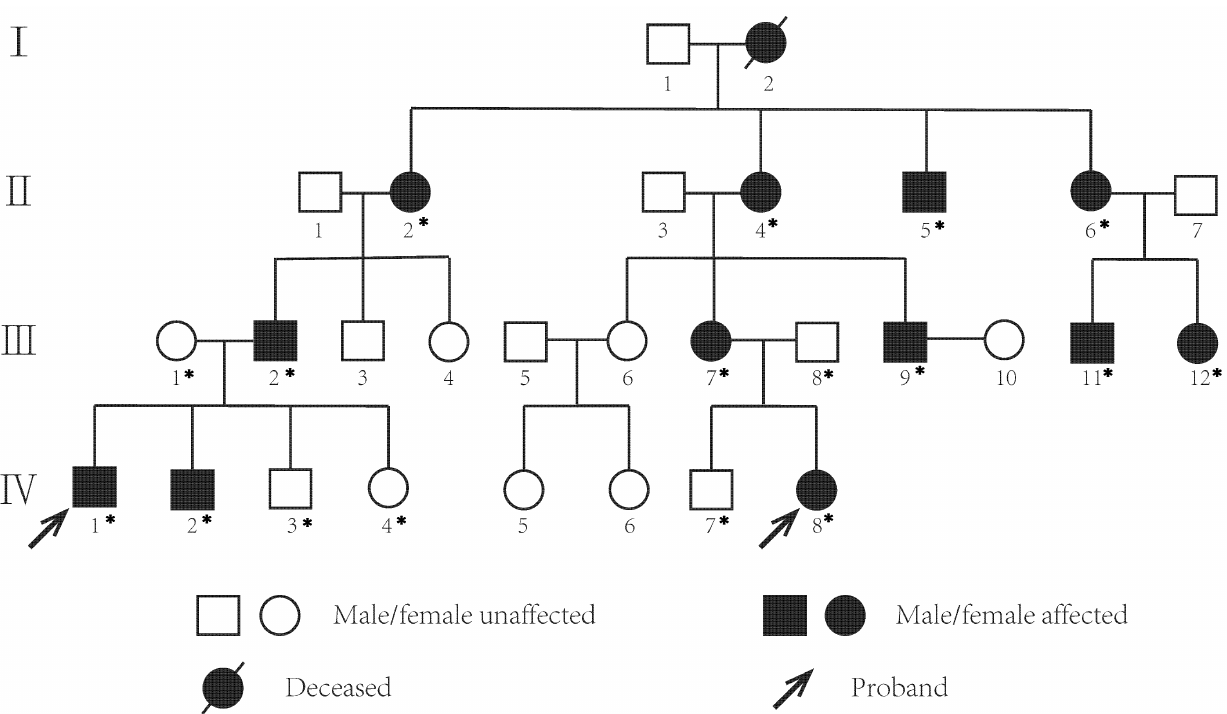
Figure 1. Pedigree of a Chinese family with congenital aniridia. Filled squares and circles denote affected males and females, respectively. Normal individuals are shown as empty symbols. The proband is indicated by an arrow. DNA samples used for sanger sequencing are marked with an asterisk.